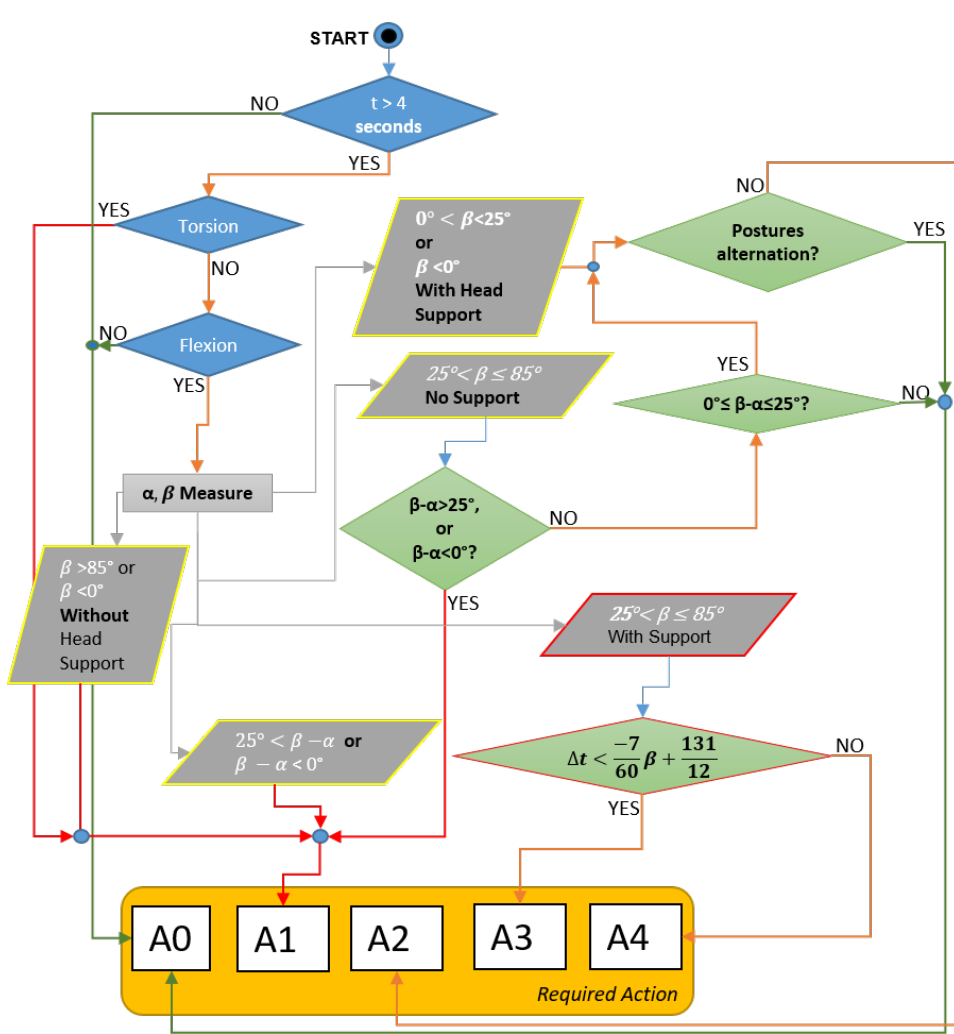
Figure 6. Overview of the procedure to evaluate the posture of the head, where: A0 stands for “acceptable”; A1 means “not recommended—workstation redesign”; A2 stands for “not recommended—workflow redesign”; A3 means “not recommended—need for recovery time”; A4 means “not recommended—reduction of holding time”.